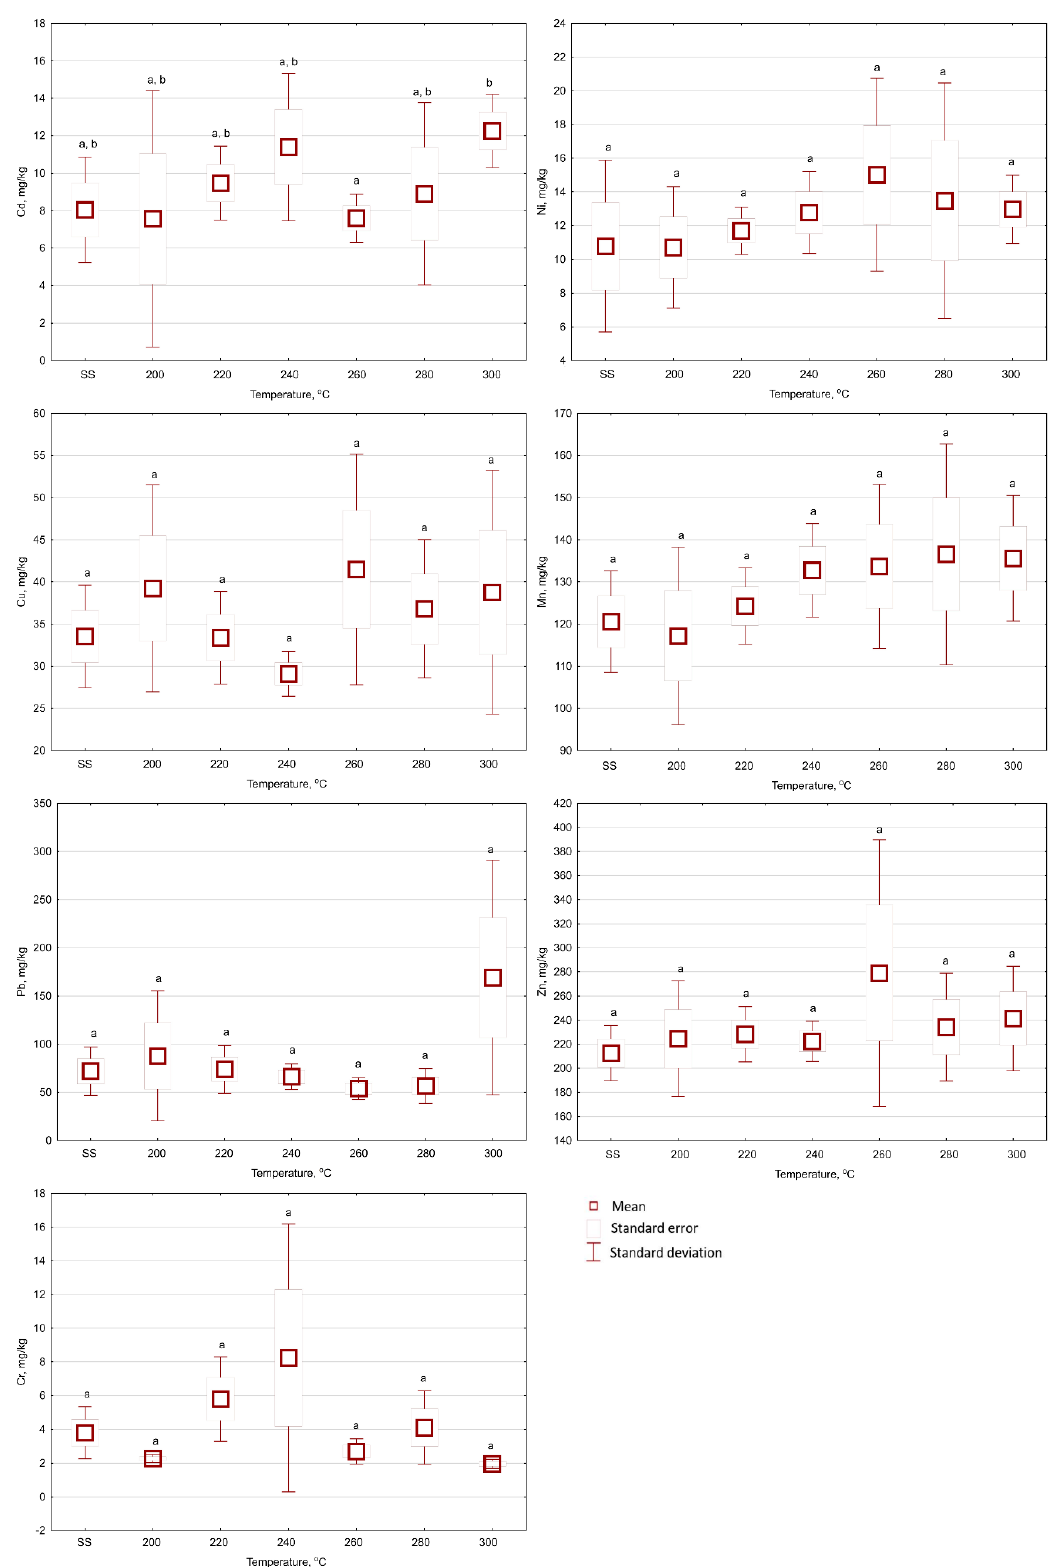
Figure 2. The influences of temperature on Cd, Ni, Cu, Mn, Pb, Zn, and Cr contents in biochars produced with 20 min of retention time under 200–300 °C temperatures (SS—raw sewage sludge). Letters indicate the statistically significant ( p < 0.05) differences between mean values.